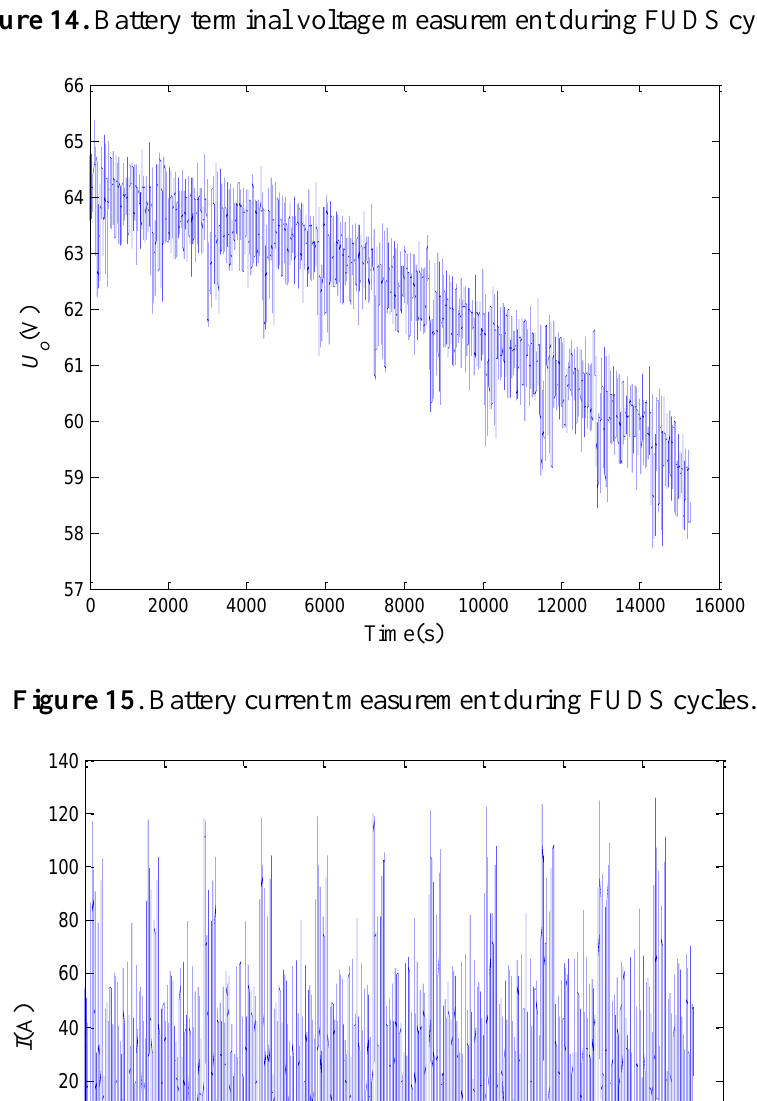
Figure 14. Battery terminal voltage measurement during FUDS cycles.